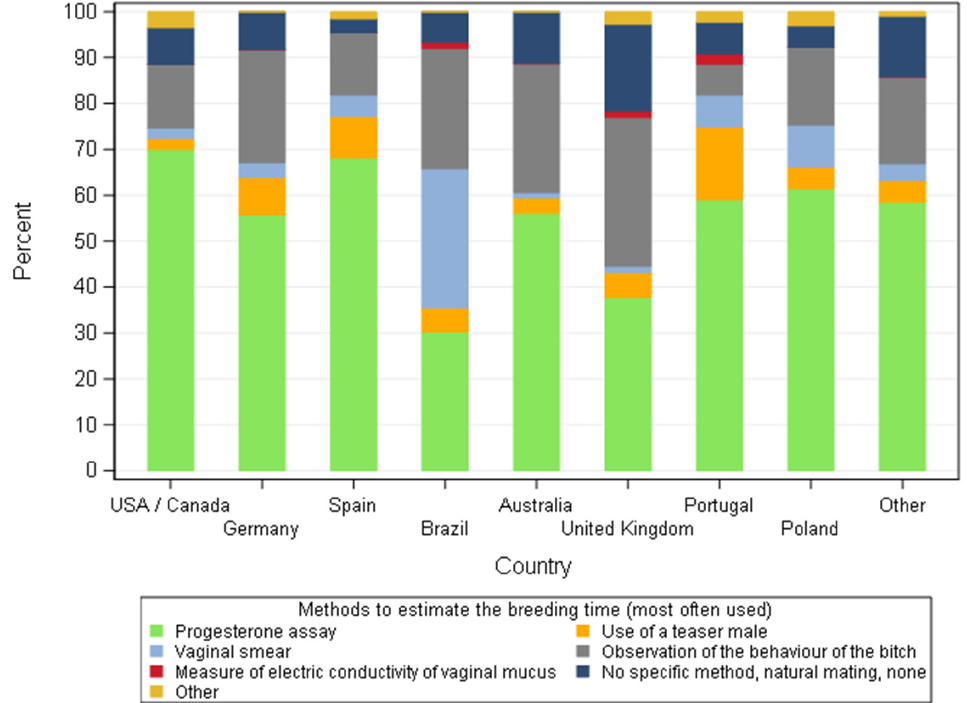
Figure 8. Methods, most often used, to estimate the breeding time according to dog breeders by country—all responders ( n = 668).